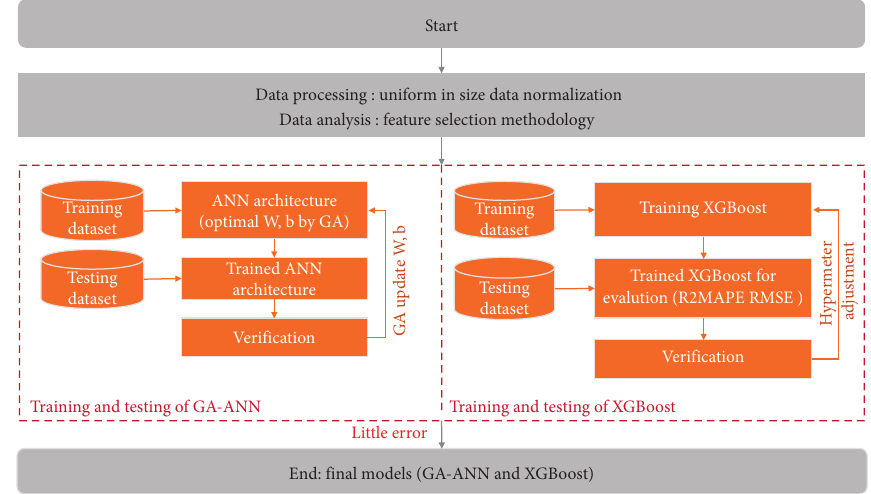
Figure 1: The overall process of GA-ANN and XGBoost for predicting the compressive strength of concrete. Table 1: Data source and number of